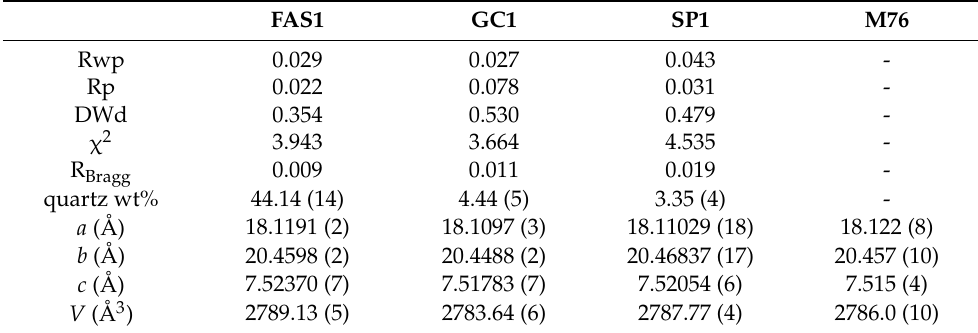
Table 6. Miscellaneous data of the refinements. Statistic indicators as defined in Young [84]. Data of Mortier et al. [81] are reported for comparison (M76).